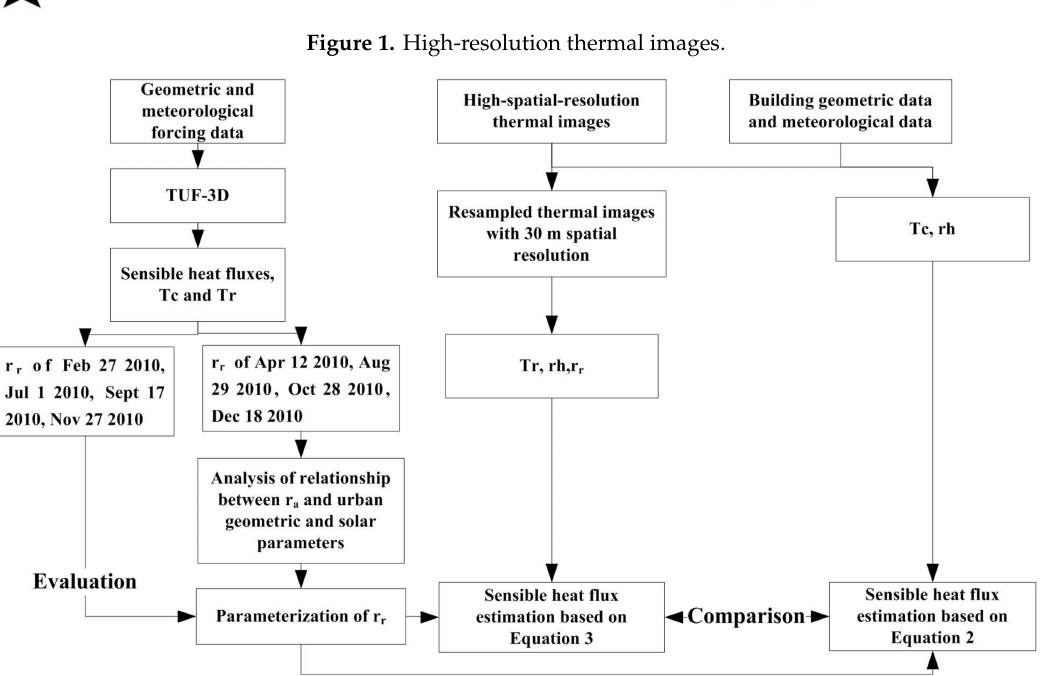
Figure 2. Flow chart of this